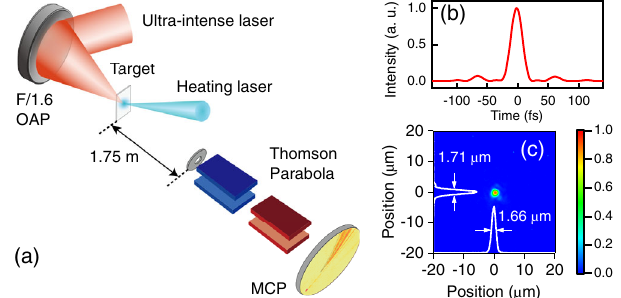
FIG. 1. (a) Experimental setup. (b) Temporal profile and (c) focal spot of driving laser